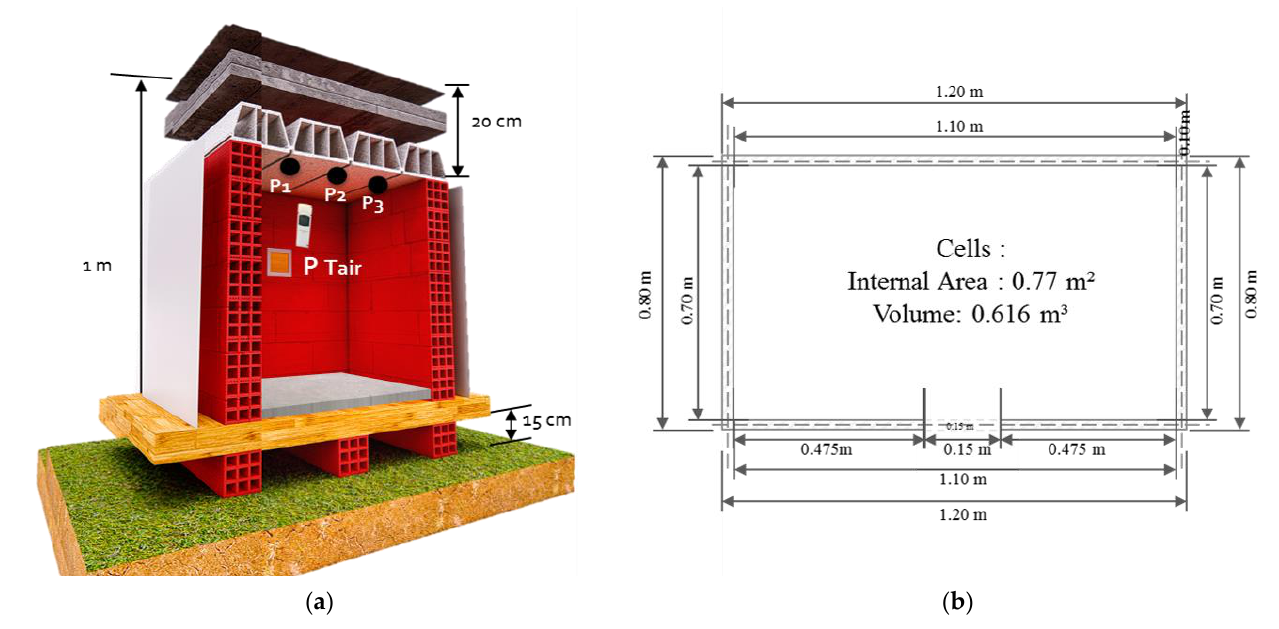
Figure 5. ( a ) 3D section of the base case test cell showing interior measurement points. ( b ) Plan and dimensions of a test cell. dimensions of a test